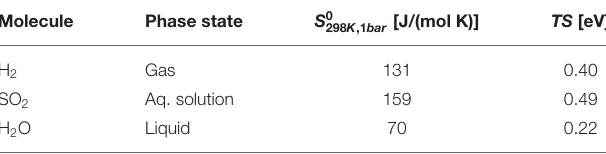
TABLE 1 | Entropy and entropic energy of the